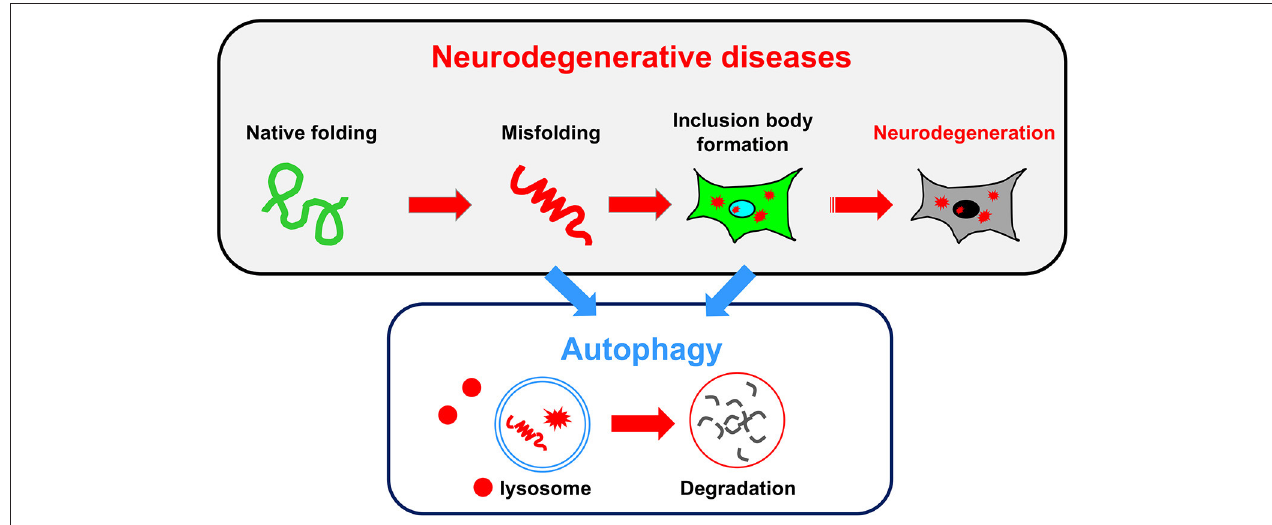
FIGURE 2 | Relationship between neurodegenerative diseases and autophagy. A common pathology shared by several neurodegenerative diseases is the accumulation of misfolded proteins and inclusion bodies. Autophagy may be useful for degrading both misfolded proteins and inclusion